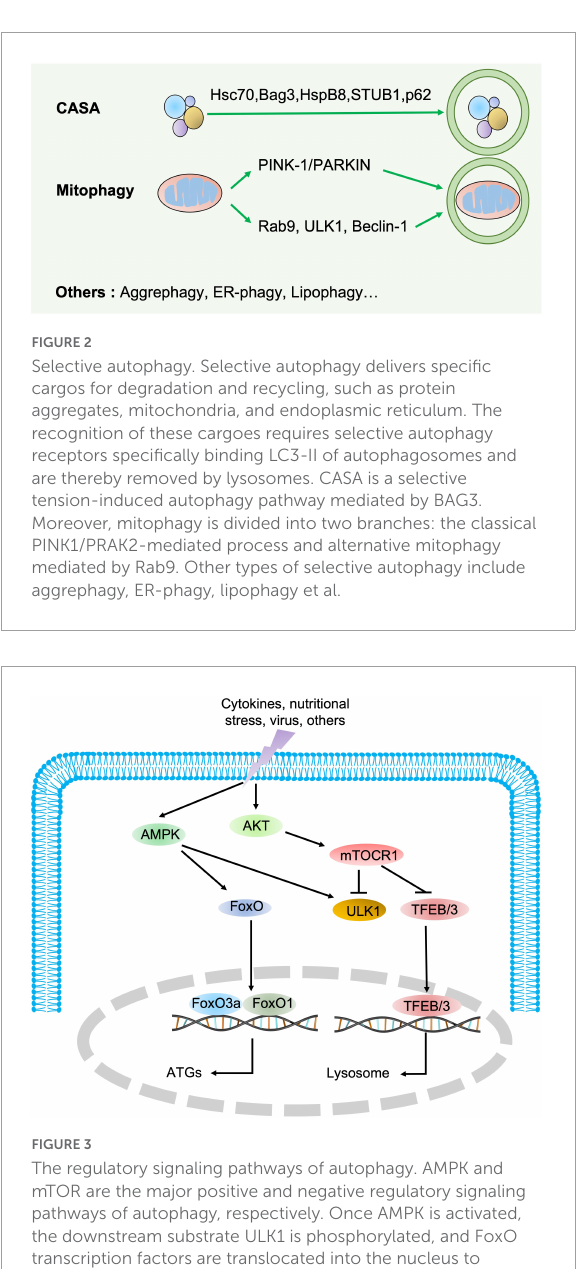
FIGURE3 The regulatory signaling pathways of autophagy. AMPK and mTOR are the major positive and negative regulatory signaling pathways of autophagy, respectively. Once AMPK is activated, the downstream substrate ULK1 is phosphorylated, and FoxO transcription factors are translocated into the nucleus to promote the expression of autophagic genes. Conversely, mTOR blocks autophagic initiation by negatively phosphorylating ULK1 and inhibits lysosome biosynthesis by blocking TFEB/TFE3 translocation into the